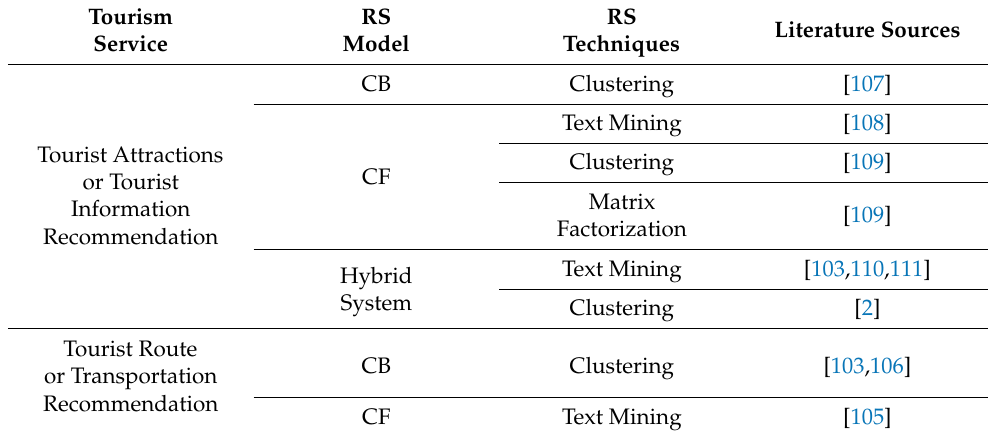
Table 7. Research on the recommendation system in tourism service